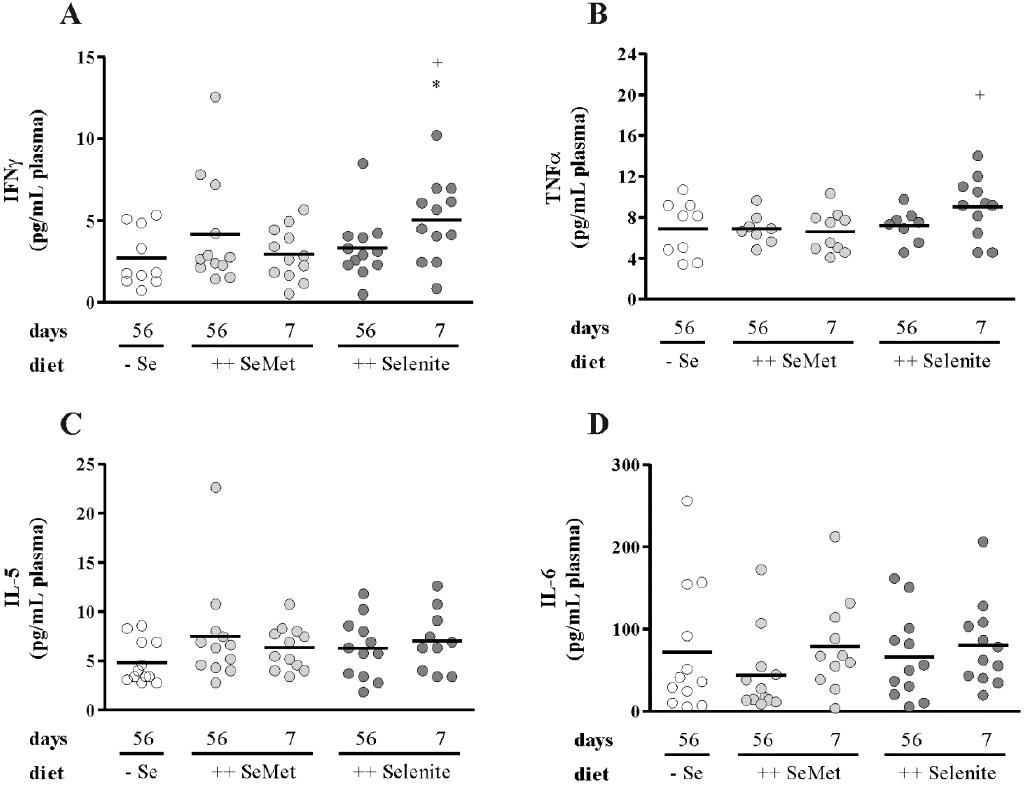
Figure 5. Th1-cytokines are increased in plasma of short-term selenite supplemented mice, while Th2-cytokines are unaffected. ( A ) IFNγ, ( B ) TNFα, ( C ) IL-5 and ( D ) IL-6 plasma levels were measured by multiplex immunoassay. Each point represents one mouse. Lines indicate means. Significant differences were calculated by Student’s t -test. * p < 0.05 vs . − Se 56 days; + p < 0.05 vs . ++ SeMet 7